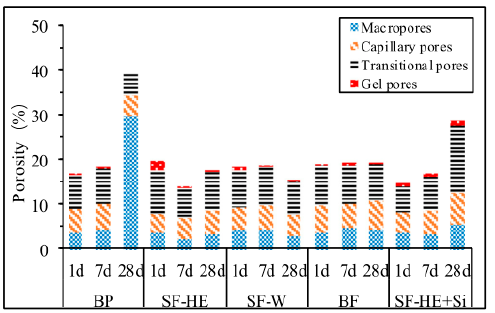
Figure 20. Porosity of different pores under different conditions [108]. BP: non-fiber material; SF-HE: 1% hook-end steel fiber; SF-W: 1% corrugated steel fiber; BF: 0.1% basalt fiber; SF-HE+Si: 1% steel fiber and 5% silica fume.